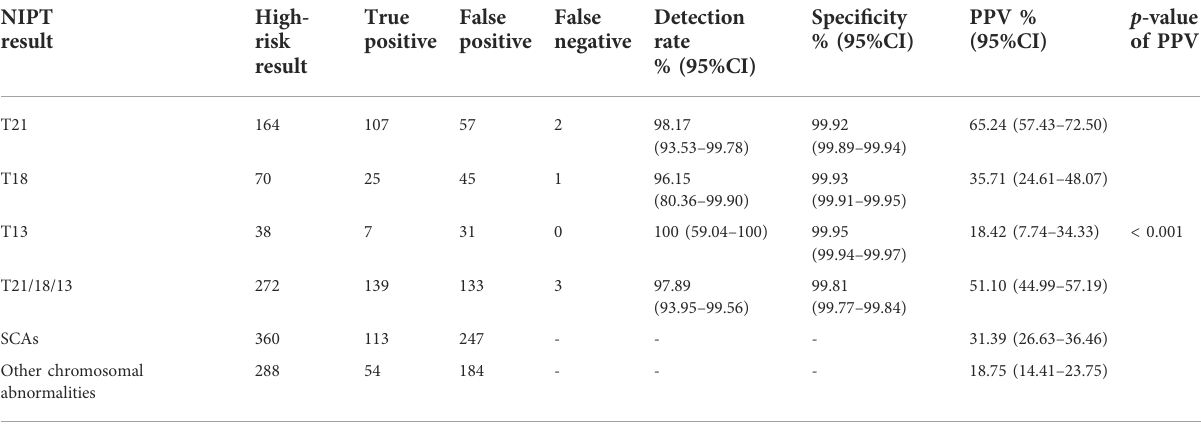
TABLE 2 NIPT positive results for T21/T18/T13/SCAs and other chromosome